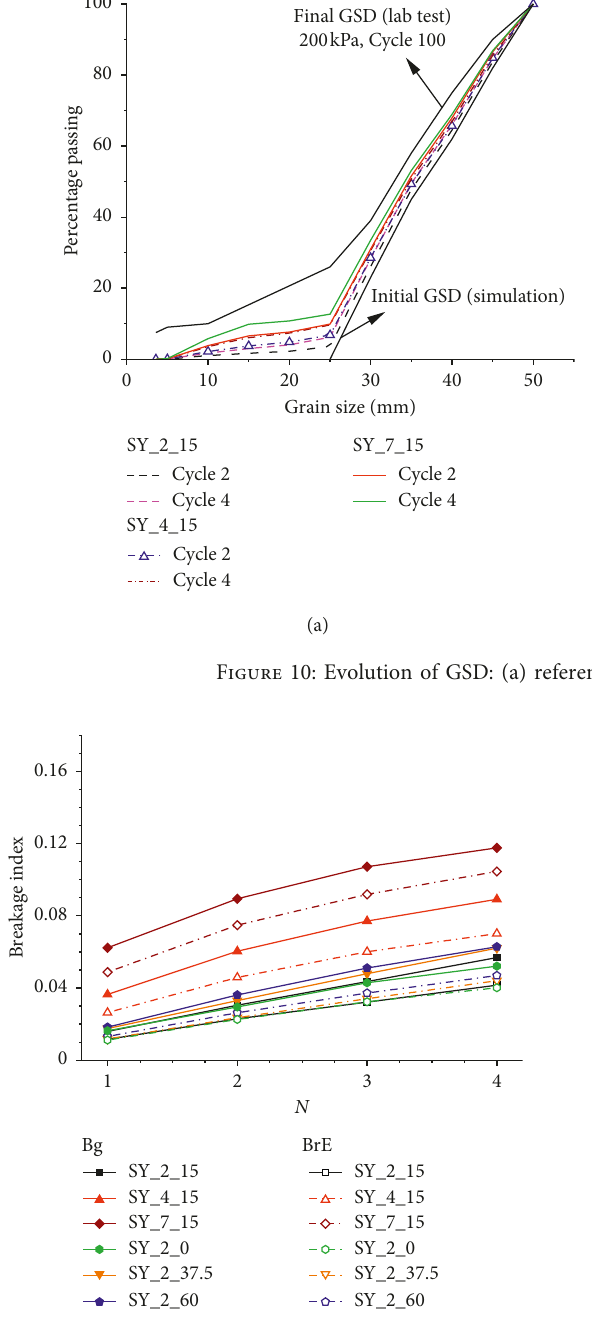
Figure 11: Evolution of two kinds of breakage indices. N , the number of shear